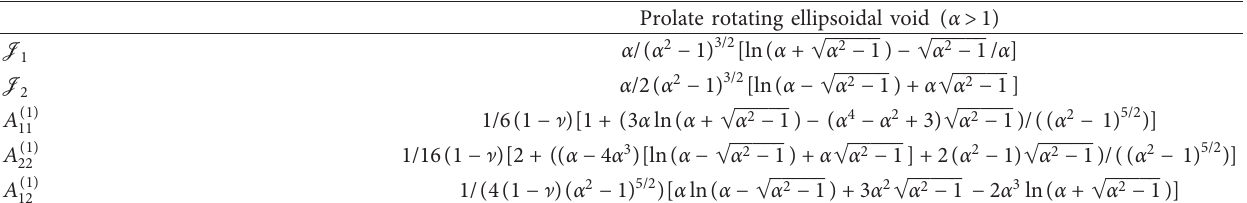
Table 10: Components for prolate rotating ellipsoidal void. Prolate rotating ellipsoidal void ( α > 1 )